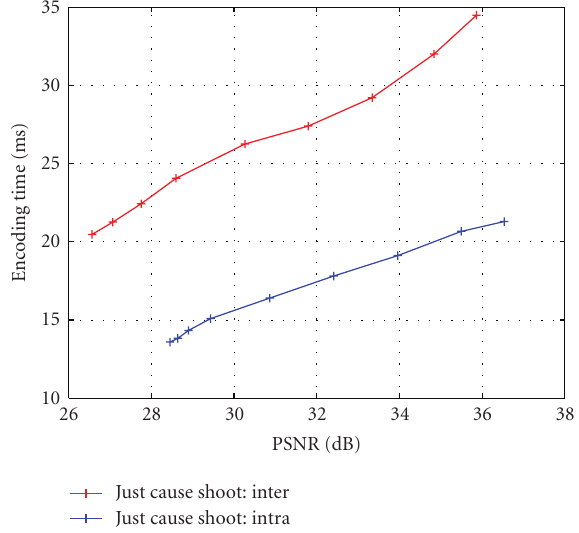
Figure 3: Comparison encoding timings for di ff erent quantizer